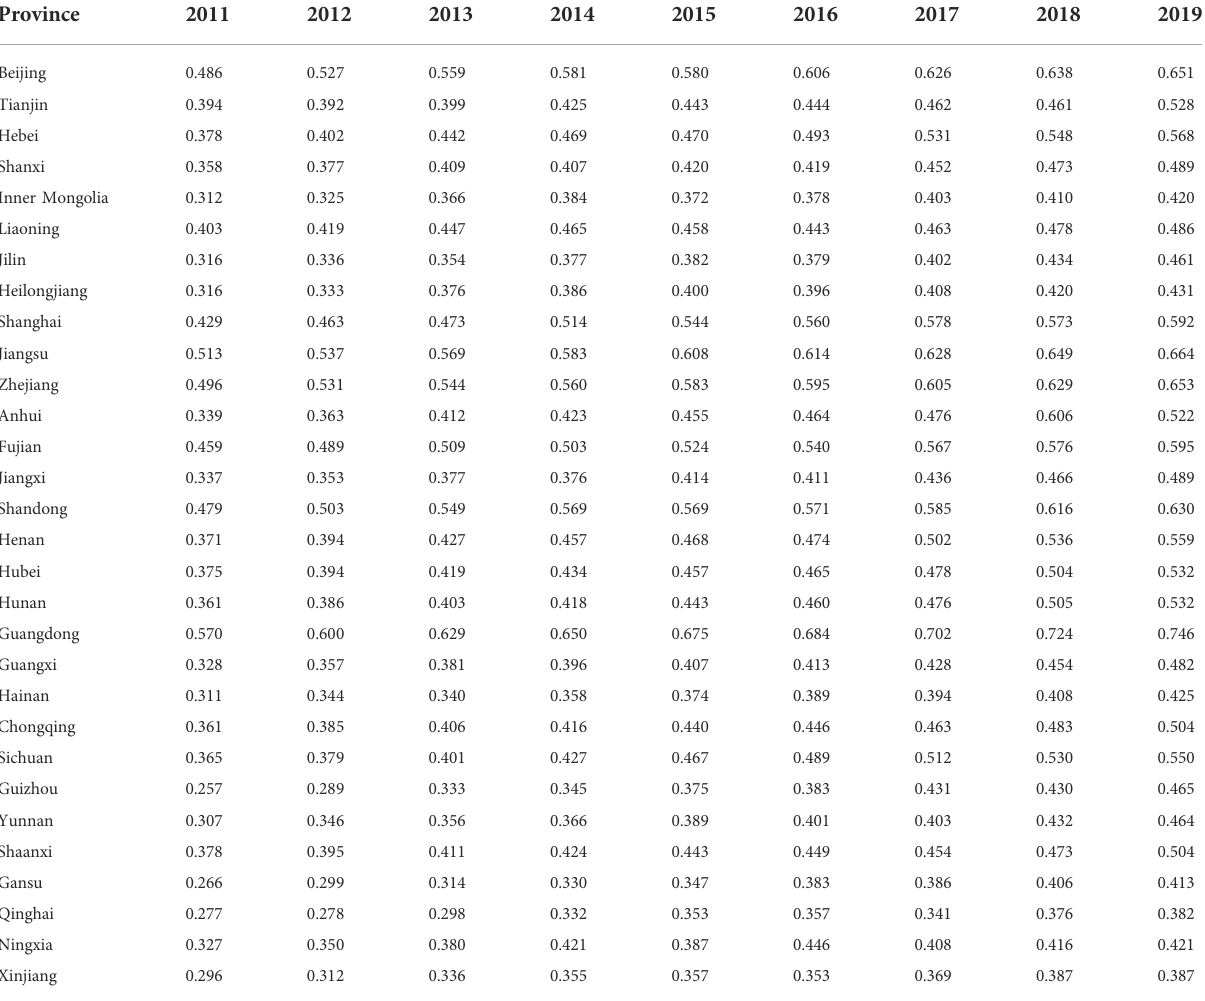
TABLE 2 The score of coupling coordinated